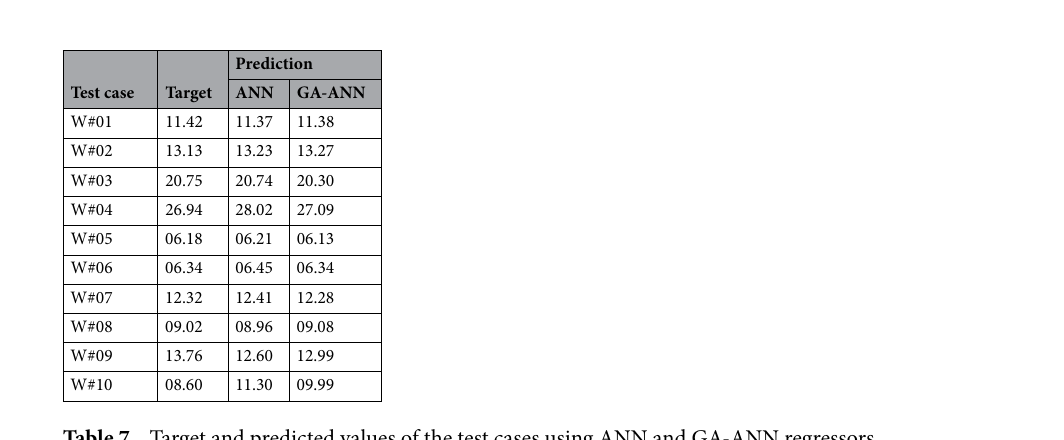
Table 7. Target and predicted values of the test cases using ANN and GA-ANN regressors.